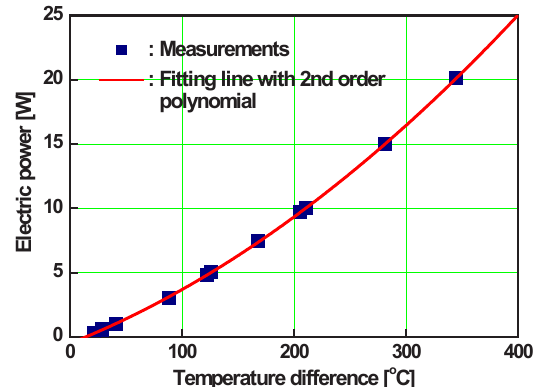
Fig. 4. Result of the calibration experiment.